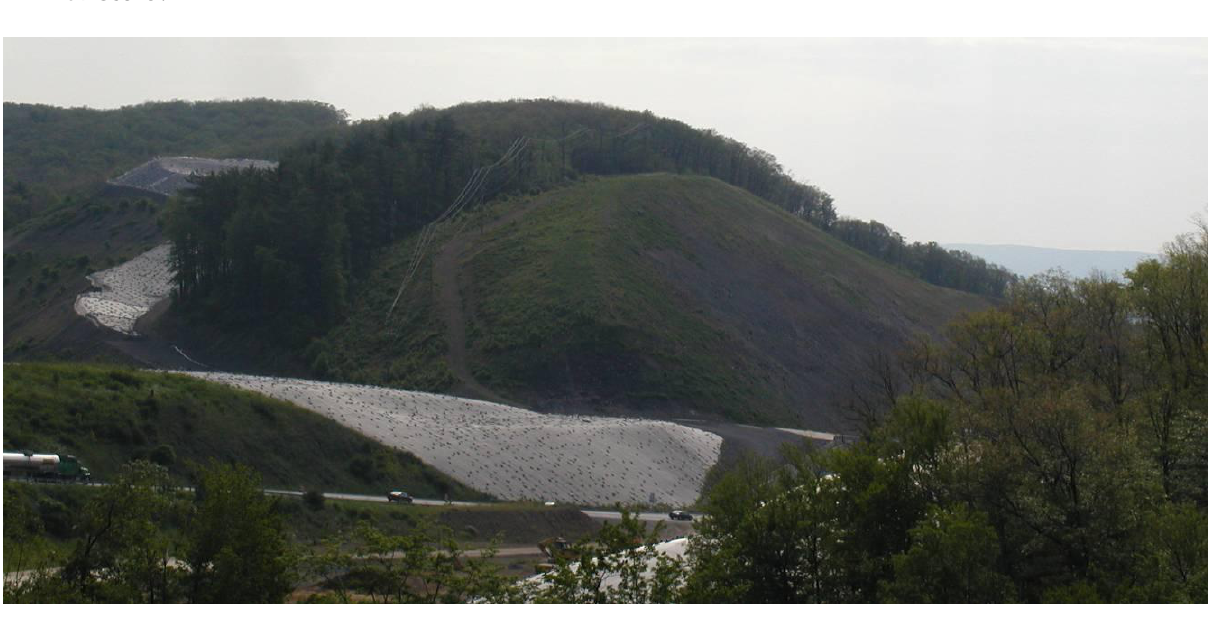
Figure 4. Photo of the Large Cut Face and neighboring temporary stockpiles (covered in black PVC geomembrane) prior to cover system construction. Vehicles are shown for